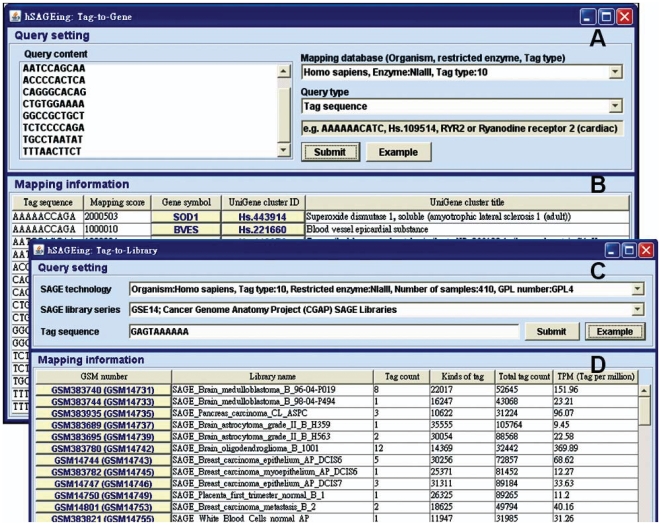
Screenshot of the tag-to-gene and tag-to-library functions.The interface is divided into (A and C) query settings and (B and D) mapping information. (A) The input contains the query content, the mapping database, and the query types. (B) The output contains a list of mapping information (tag sequence, mapping score, gene symbol, UniGene cluster ID, and UniGene cluster title). (C) The input contains the SAGE technology, the SAGE library series, and the tag sequence. (D) The output contains a list of mapping information (GSM number, library name, tag count, kinds of tag, total tag count and TPM. Since the GEO recently renames some SAGE libraries, we expressed the SAGE library name as a new GSM no. (old GSM no.).